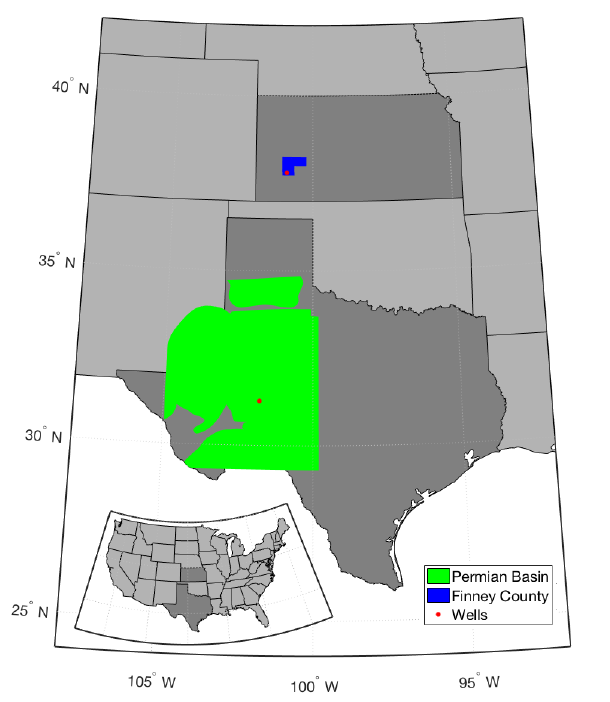
Figure 3. Map showing the location of wells used in this study. One well is located in the Permian Basin in Texas and the other well is located in Finney County in an oil-producing field within the Hugoton gas area in